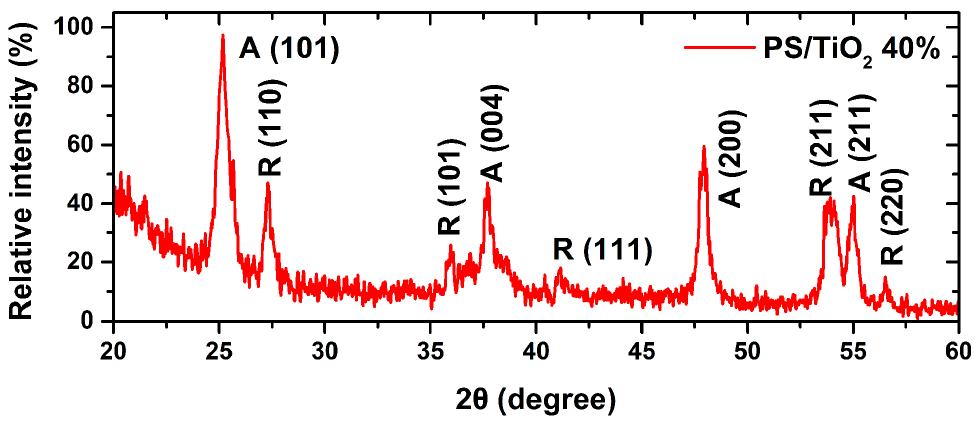
Figure 2. Typical X-ray di ff raction (XRD) patterns for PS / TiO 2 3D-printed nanocomposite structures.